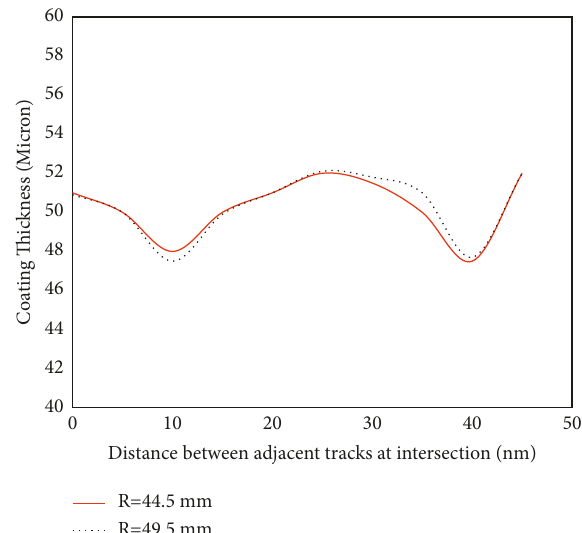
Figure 7: Coating thickness distribution at the intersection of the large-curvature conical surface and the approximately flat